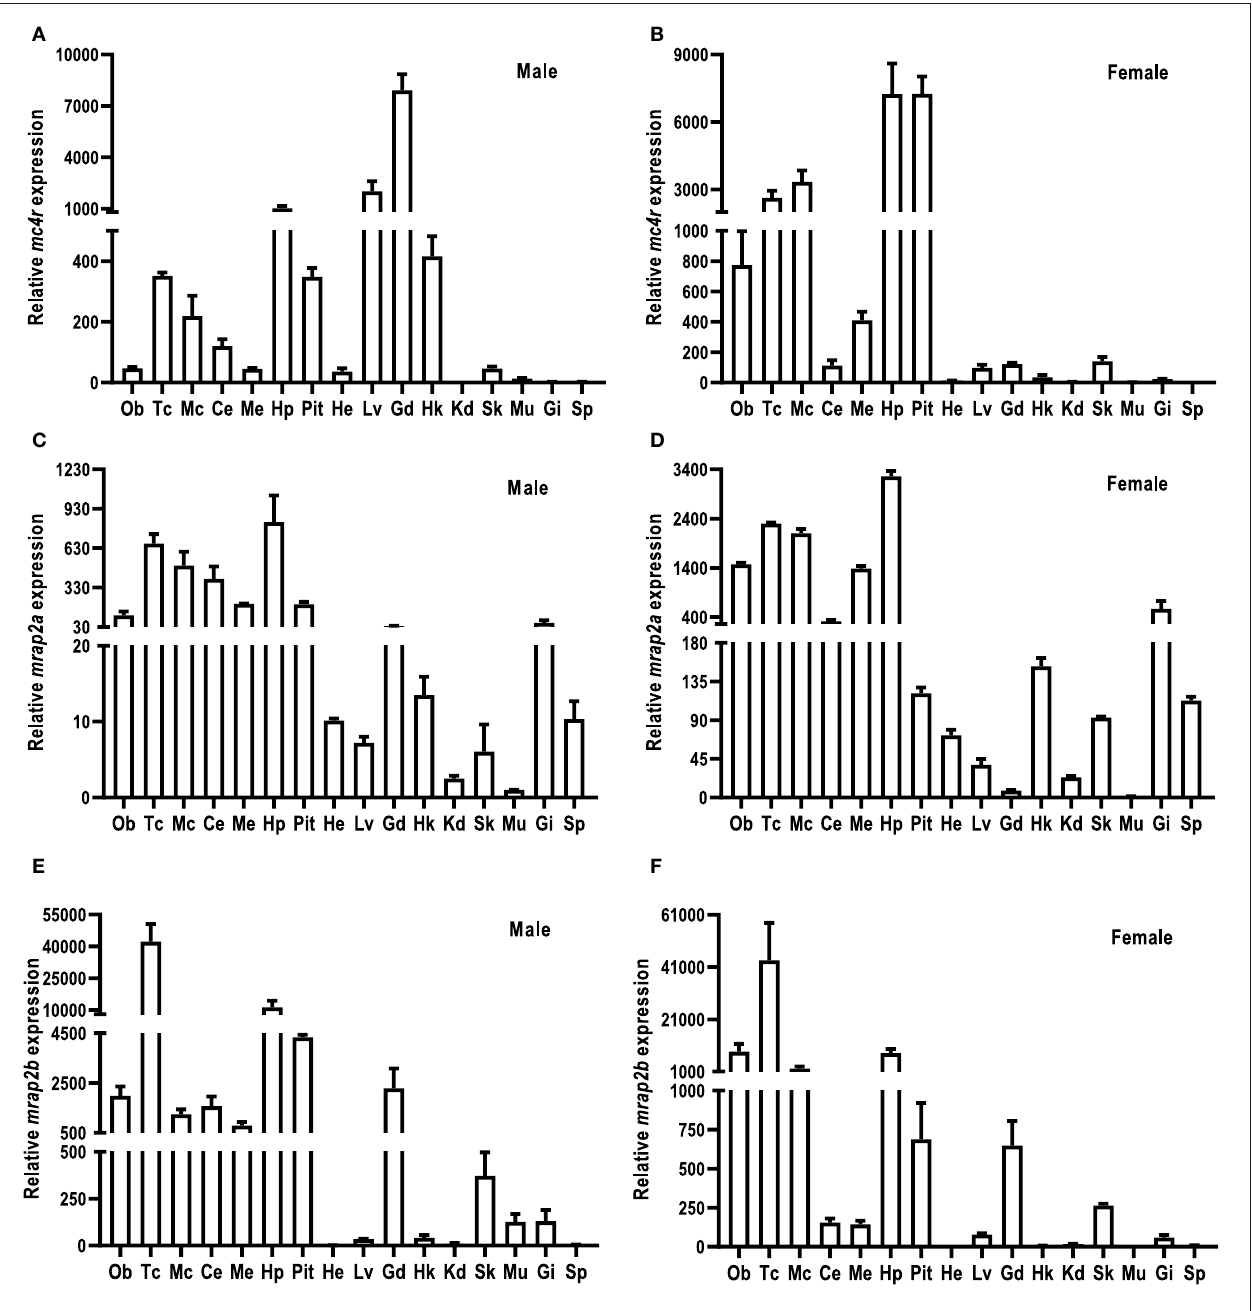
FIGURE 3 | Expression of culter mc4r (A,B) , mrap2a (C,D) and mrap2b (E,F). The mRNA levels of mc4r , mrap2a , and mrap2b were measured by qRT-PCR. The results were calculated as the ratio of β -actin. Each data point represented the mean ± SEM ( n = 3). Ce, cerebellum; Ob, olfactory bulb; Mc, mesencephalon; Me, medulla; Tc, telencephalon; Pit, pituitary gland; Hp, hypothalamus; Lv, liver; He, heart; St, stomach; Int, intestine; Kd, kidney; Gd, gonad; Sk, skin; Sp, spleen; Hk, head kidney; Gi, gill; Mu, muscle.